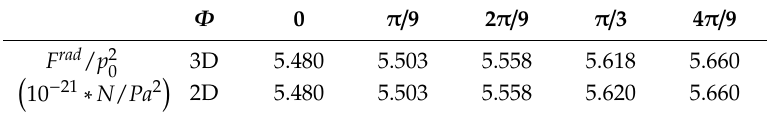
Table 3. Normalized force on a revolving body for waves with di ff erent incident directions.